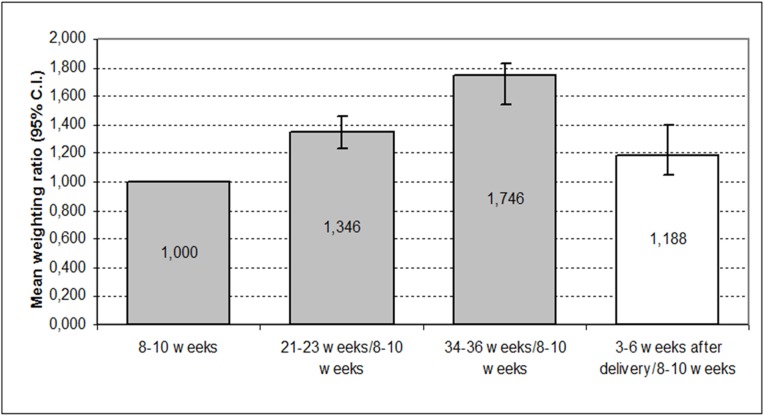
Comparisons of proportion of sites with probing depth >3mm during pregnancy and postpartum.